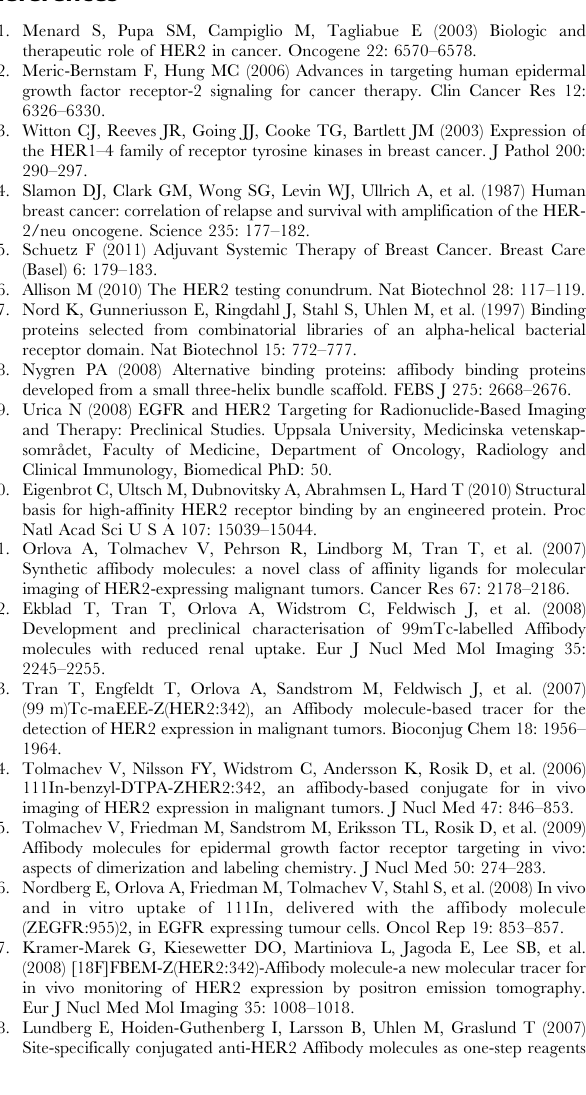
Glo, Promega, Madison, WI). Treated cells were normalized to vehicle-treated control. Table S1 Half-life of the probe determined based on changes of fluorescence signal measured on contralat- eral site as a function of time. Mice were injected IV with 10 m g of ZHER2-DyLight-750 conjugate (A) or Taq-Affibody- DyLight-750 (B). Fluorescence intensity over ROI on contralateral site was measured as described before. Half-life was calculated using one-phase decay function in GraphPad Prism software. (TIF) Movie S1 Continuous monitoring of fluorescence dis- tribution in mouse bearing s.c. BT-474 tumor injected with Z HER2 -DyLight-750 conjugate. Mouse were positioned in Pearl Impulse Imaging System (LI-COR Biosciences), cathe- terized, and injected with 10 m g of Affibody-DyLight-750